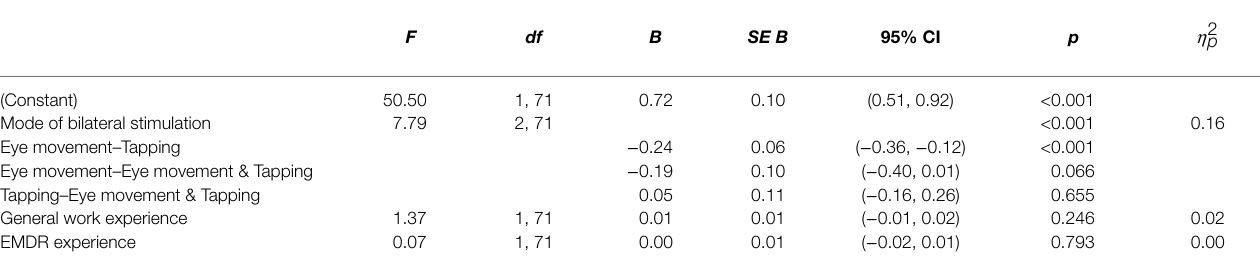
TABLE 4 | Multiple regression on the association between SUD decrease and the mode of bilateral stimulation, the therapists’ general work experience and their specific EMDR experience.